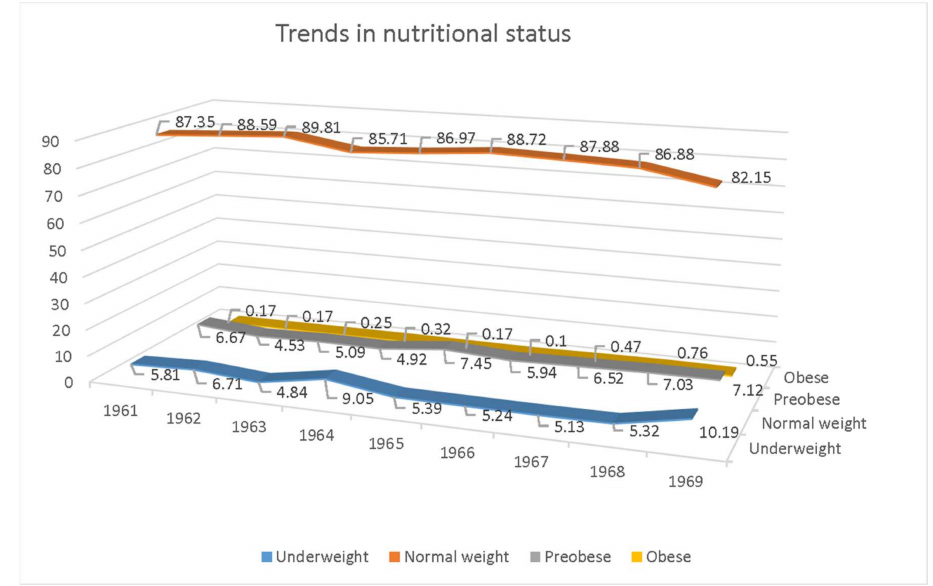
Figure 4. Trends in the nutrition status in young males from the Municipality of